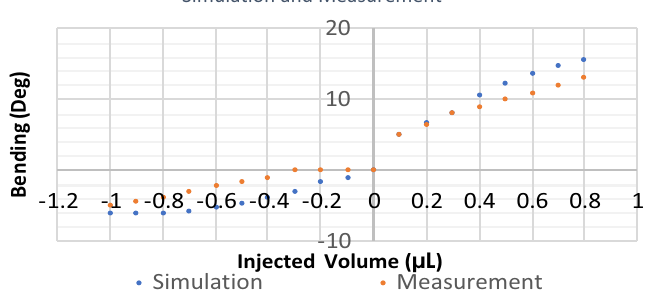
Figure 10. Comparison of the simulation and experimental measurement. The comparison between simulation and measurement for the microgripper. The simulation and experimental measurement show the same trend and almost the same slope as depicted in the figure.